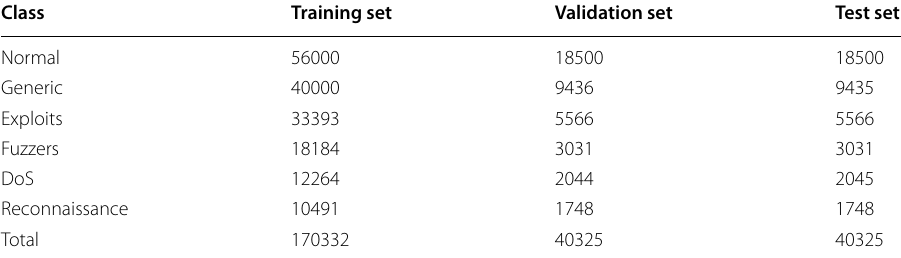
Table 4 Records of training, validation and test set to be used in our model Class Training set Normal